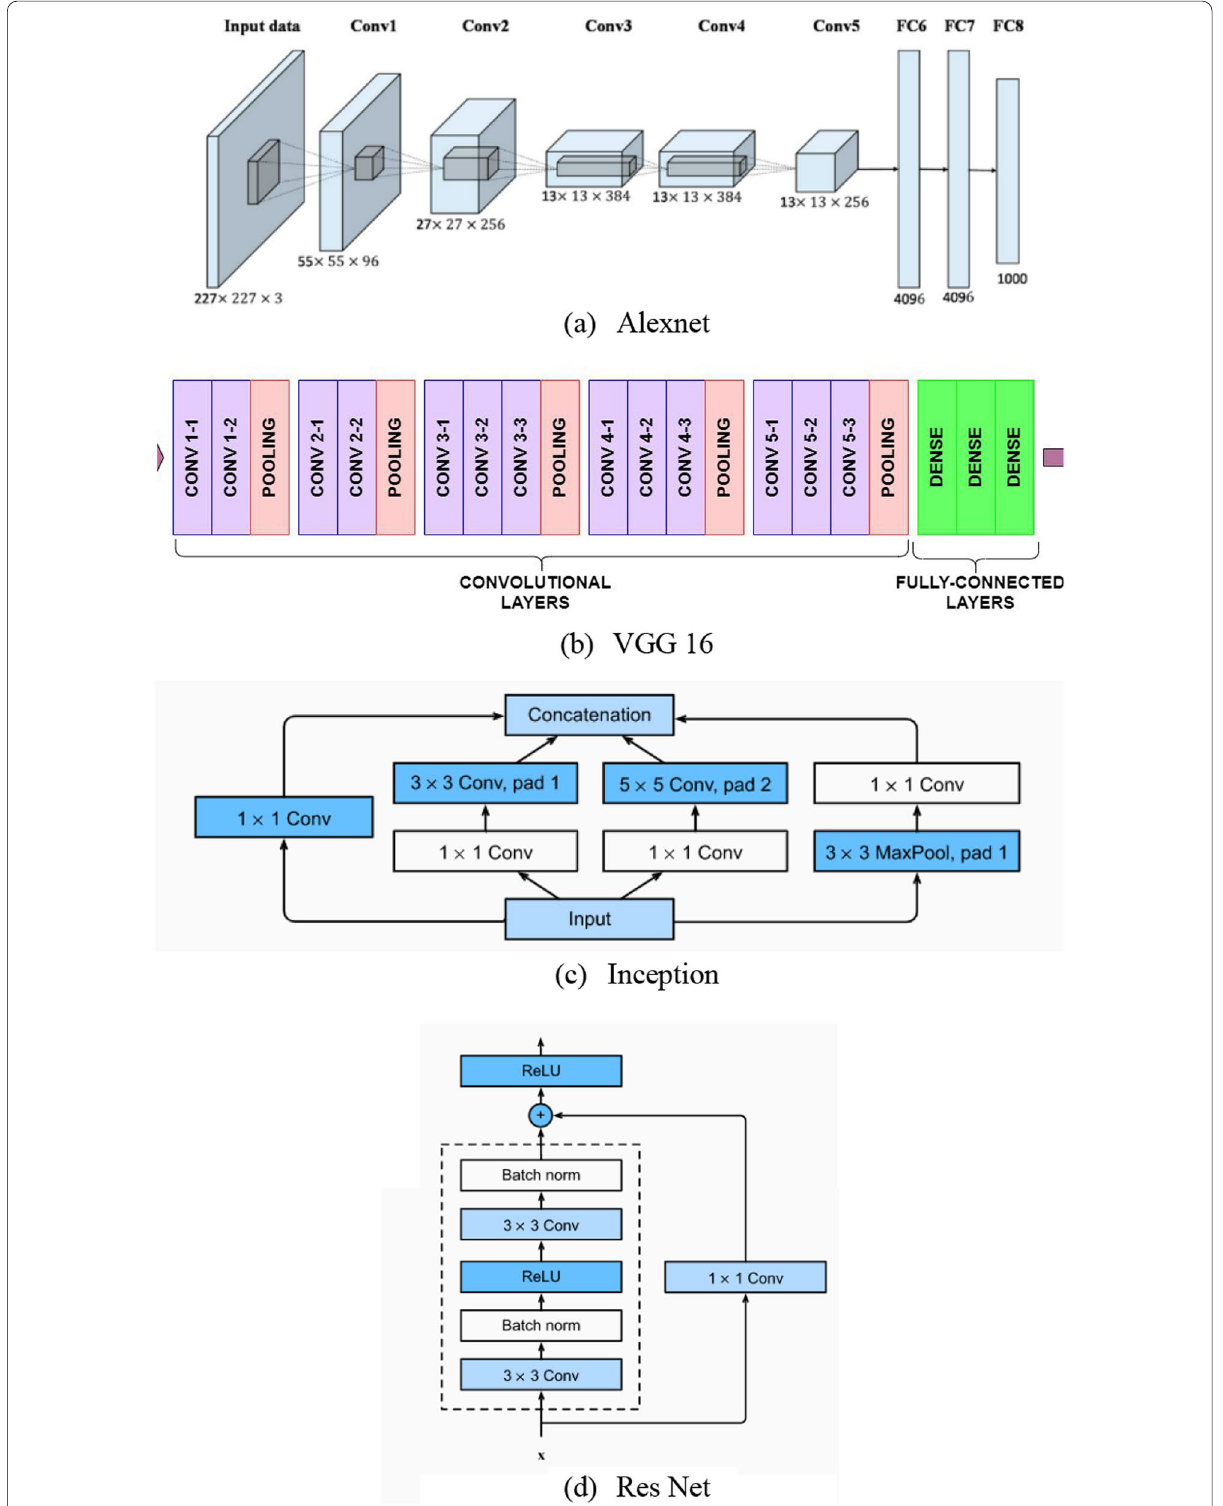
Fig. 5 Block diagram of standard Deep Learning convolutional Neural